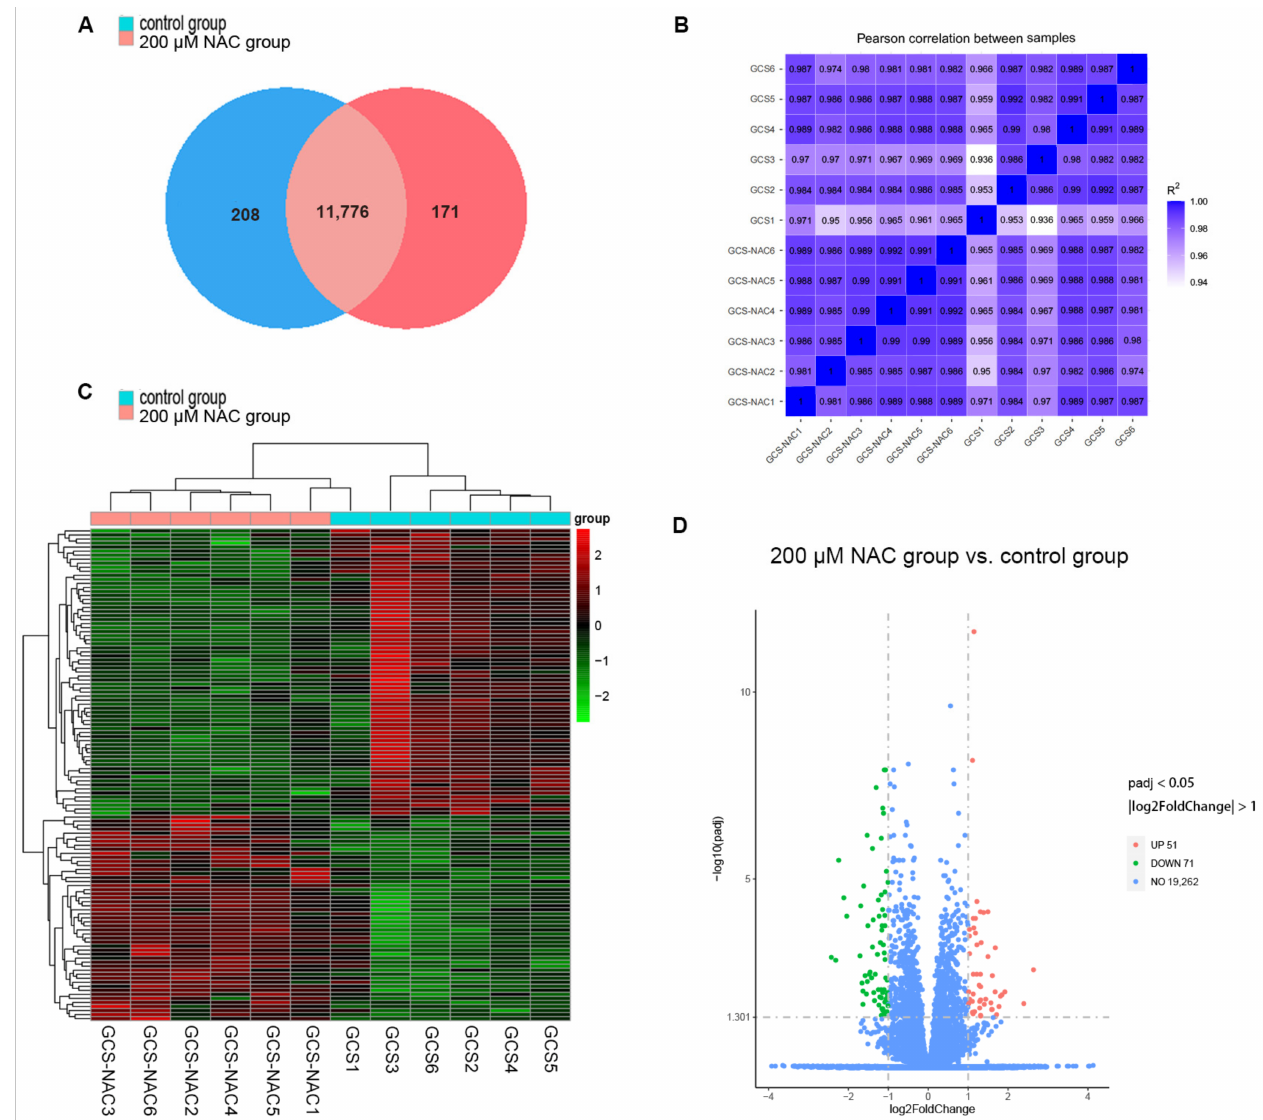
Figure 3. Analysis of gene expression. ( A ) Venn diagram of gene expression. ( B ) Pearson correlation between samples. ( C ) Heat map of the DEGs cluster analysis. Columns represent samples, and different rows represent genes. ( D ) Volcano plot of DEGs (|log2(FoldChange)| ≥ 1 and padj < 0.05). Up, upregulated DEGs; Down, downregulated DEGs. GCS-NAC1, GCS-NAC2, GCS-NAC3, GCS- NAC4, GCS-NAC5, and GCS-NAC6 are representative of the 200 µ M NAC group. GCS1, GCS2, GCS3, GCS4, GCS5, and GCS6 are representative of the control